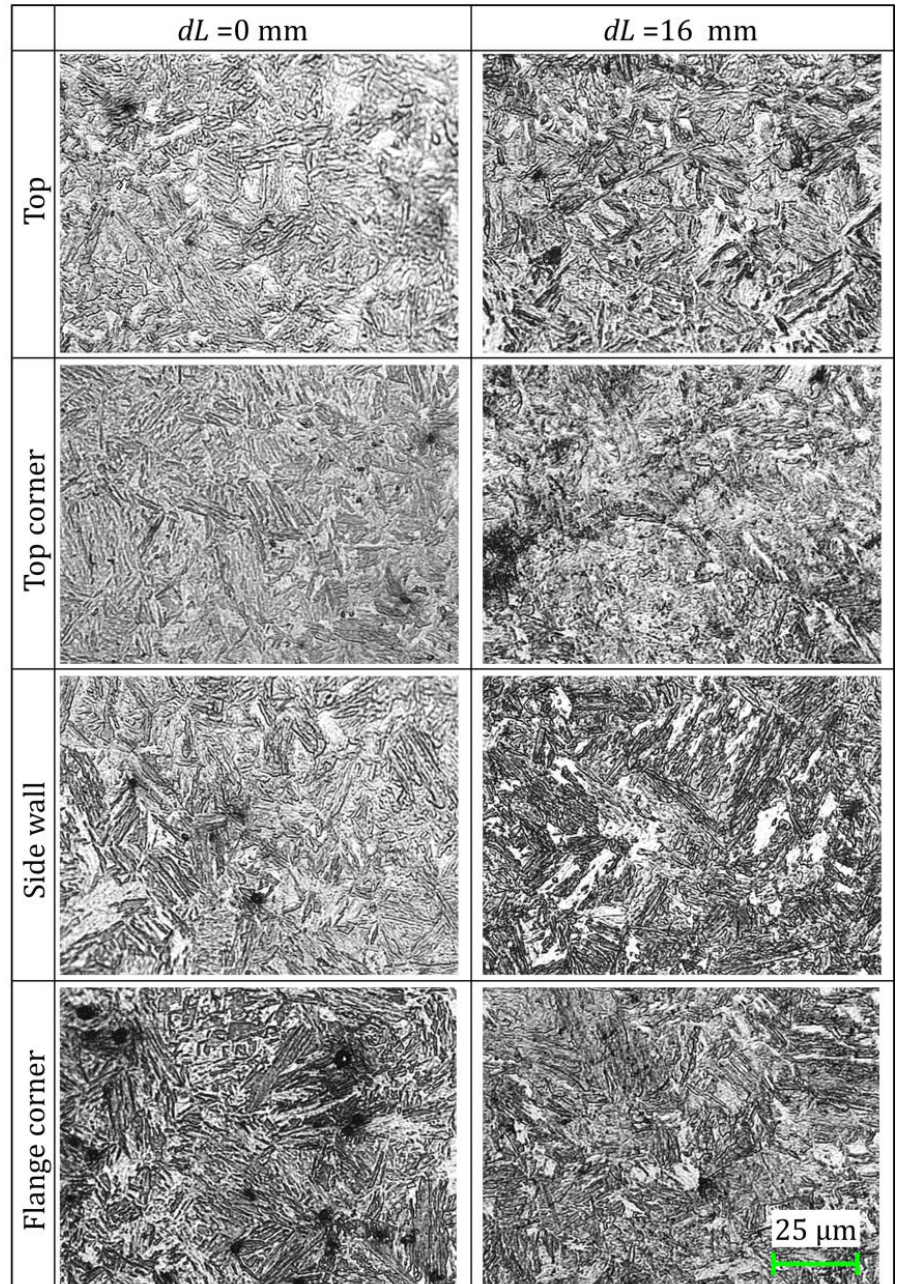
Figure 11. Microstructures of hot hat-shaped bent parts for d L = 0 and 16